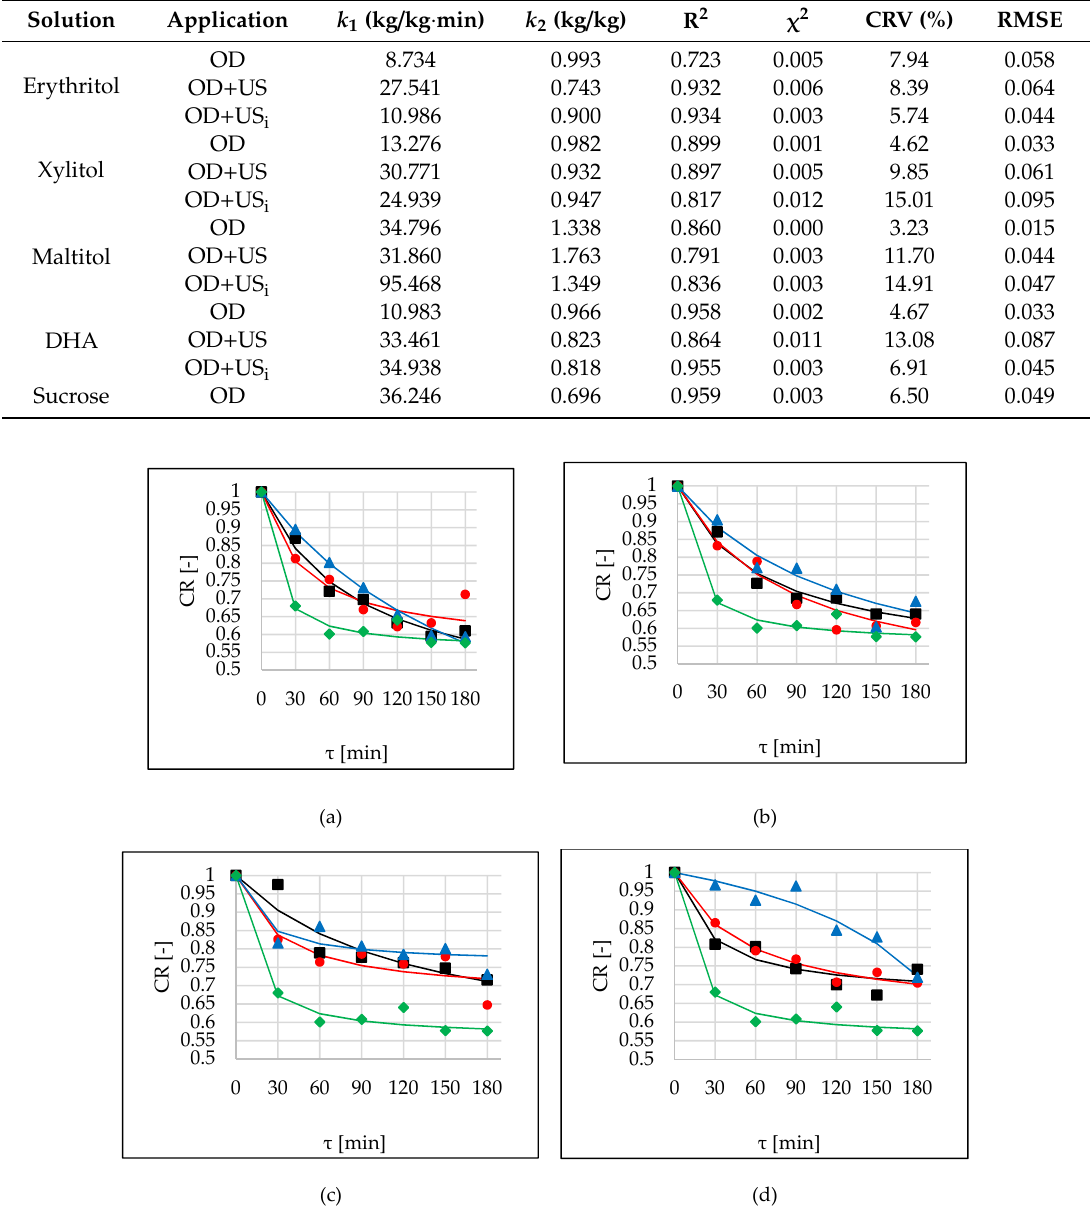
Figure 4. The Cichowska et al. ratio (CR) kinetics in several conditions (OD ( ■ ), OD+US ( ● ), OD+USi ( ▲ )) at 40 °C, in different solutions: ( a ) erythritol, ( b ) xylitol, ( c ) maltitol, ( d ) DHA. Lines are the Peleg’s model. The green line ( ♦ ) is the kinetic reference (sucrose).